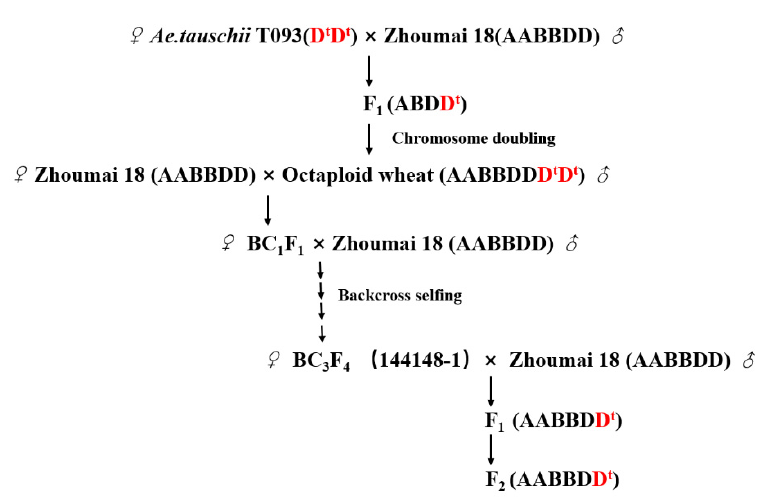
Figure 6. Crossing scheme used to obtain the F 2 population of wheat in this study. D t denotes the genome of Aegilops tauschii .